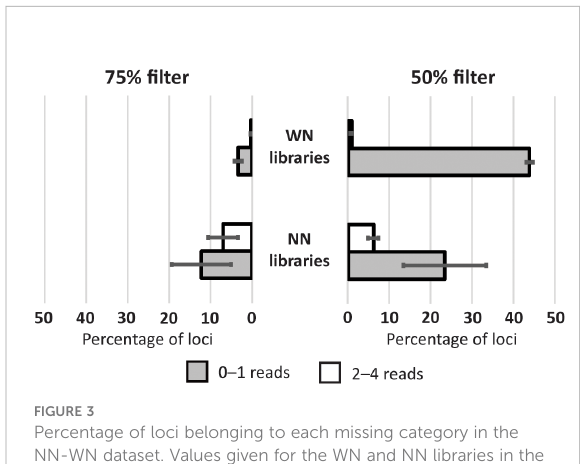
FIGURE 3 Percentage of loci belonging to each missing category in the NN-WN dataset. Values given for the WN and NN libraries in the 75% and 50% fi ltered fi